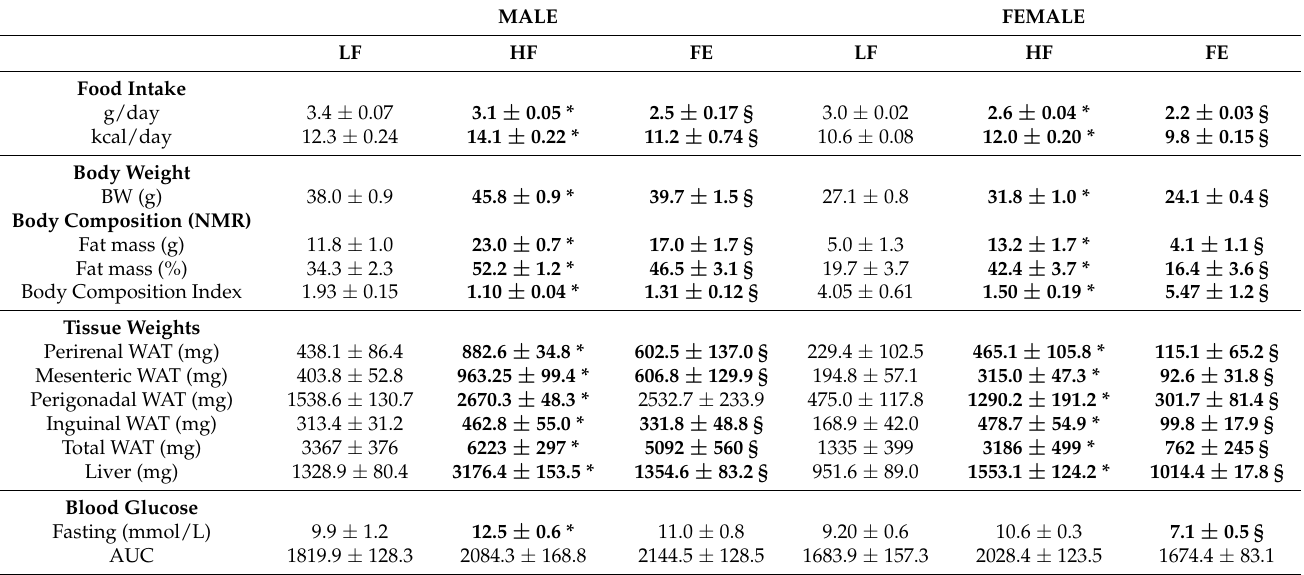
Table 1. Effects of the ‘Fertility Enhancer’ supplement on food consumption, bodyweights, body composition index, tissue weights, and blood glucose in Western diet-fed C57BL/6J mice. MALE FEMALE LF HF FE